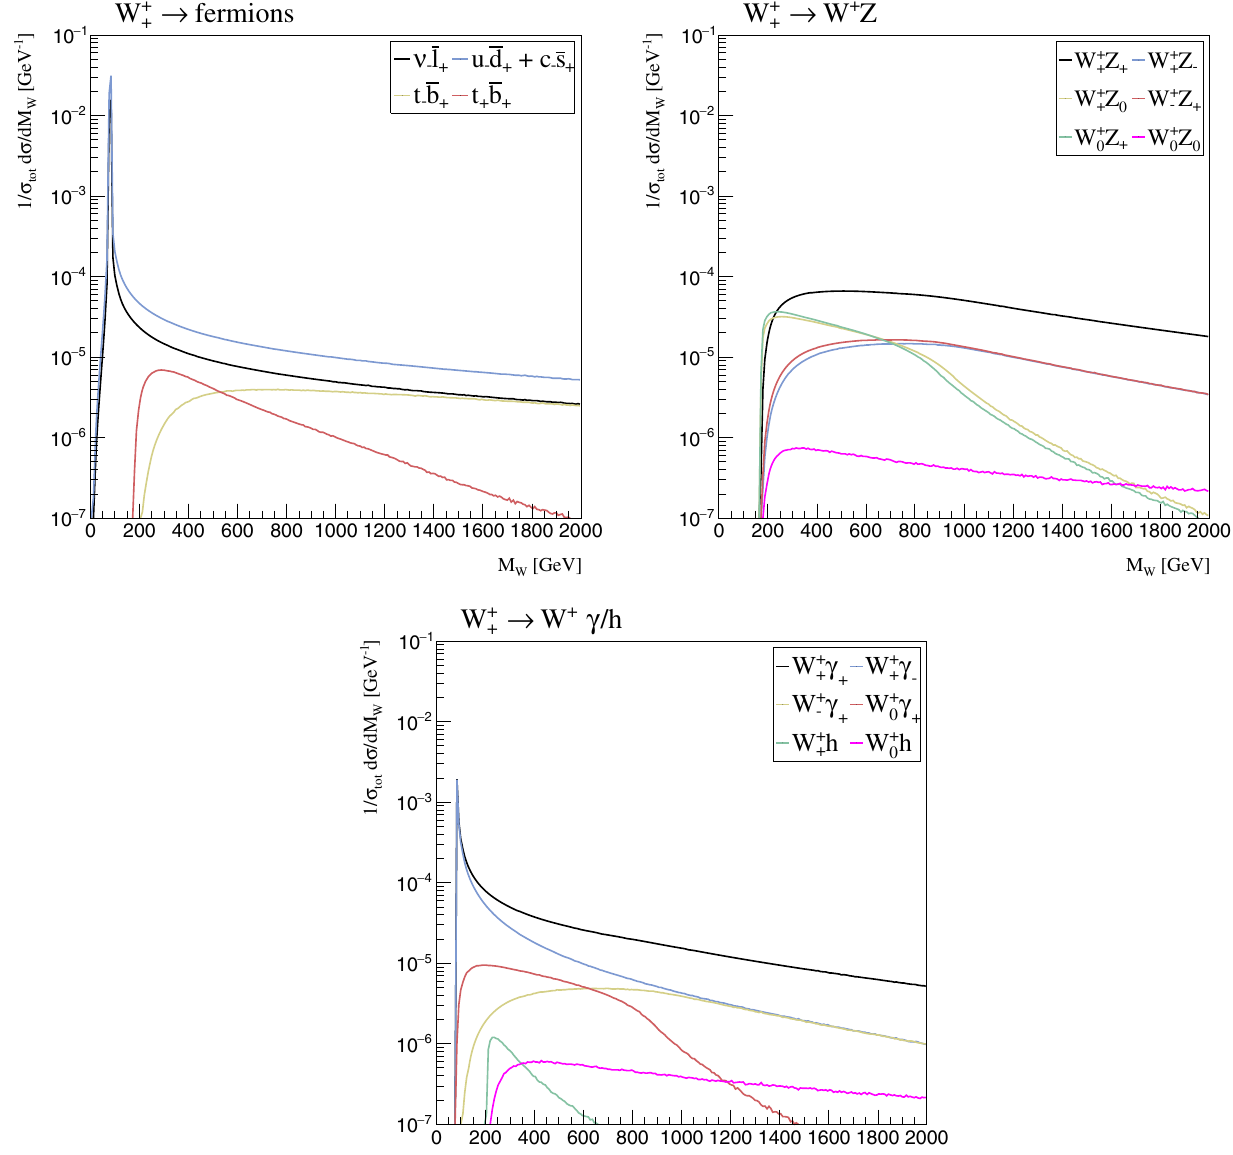
Fig. 3 Branching spectra of a 1 TeV W + + to fermions (left), W + Z (right) and W + γ/ h (bottom)